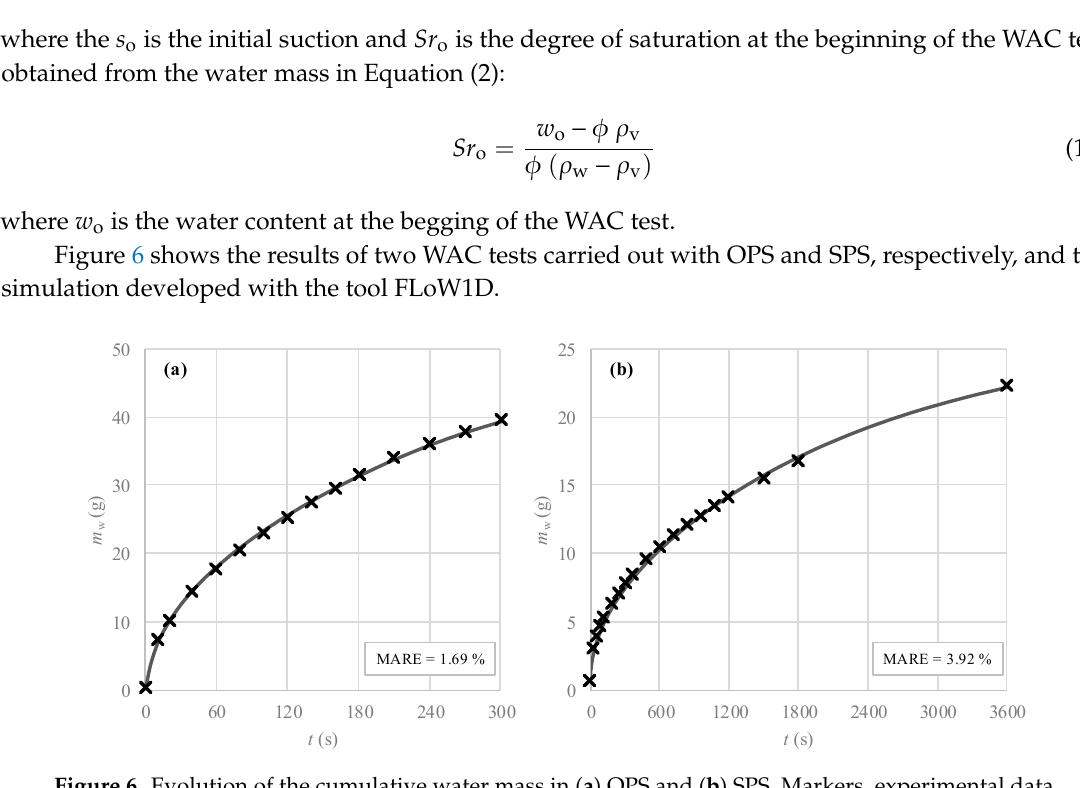
Figure 6. Evolution of the cumulative water mass in ( a ) OPS and ( b ) SPS. Markers, experimental data ( w tot,obs ); solid line, FLoW1D results ( w tot,cal ).